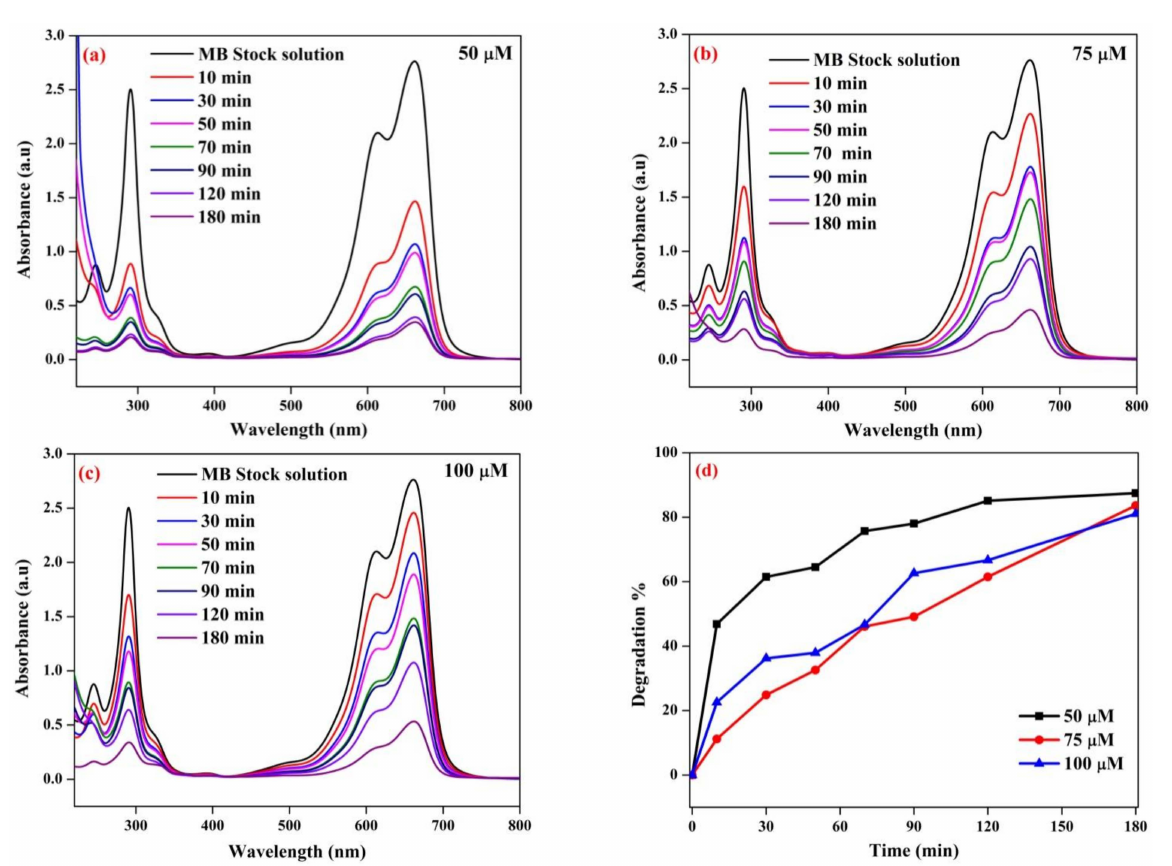
Figure 12. Photocatalytic degradation of methylene blue at ( a ) 50 µ M, ( b ) 75 µ M, and ( c ) 100 µ M. ( d ) Degradation efficiency of Cu-Zn-Mn trimetal oxide